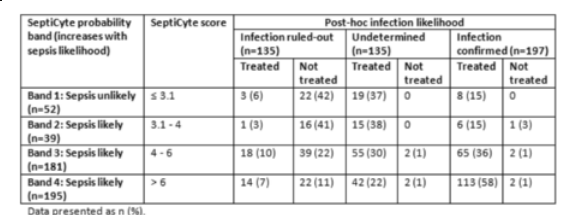
Fig. 1 (abstract A6). SeptiCyte LAB result versus post-hoc infection likelihood in 467 critically ill patients with acute respiratory failure, stratified by receiving or not receiving antibiotic treatment on the first day in ICU